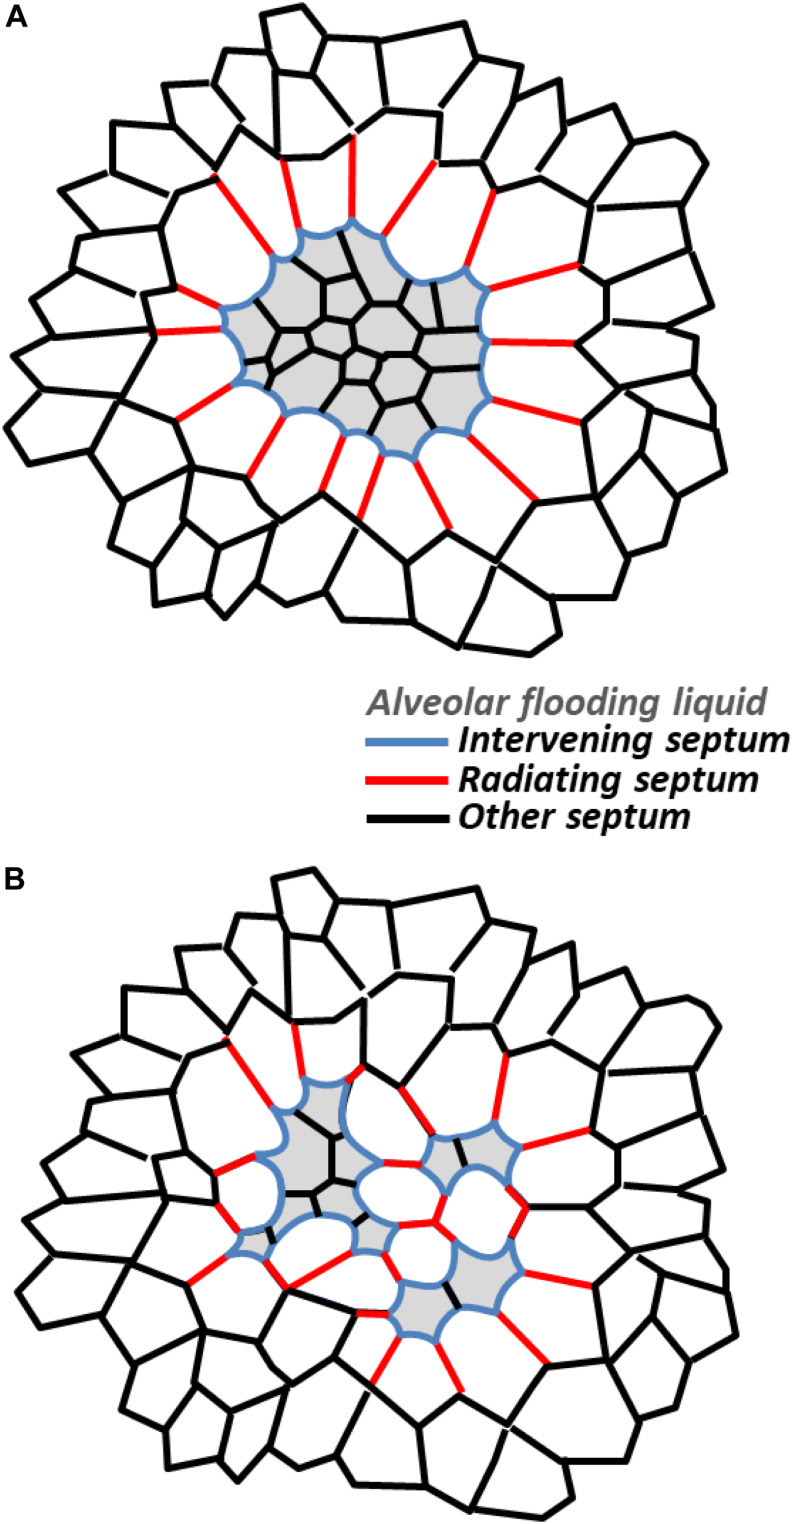
Stress concentrations in injured regions. Schematic representations showing stressed intervening and radiating septa in (A) homogeneously and (B) heterogeneously flooded regions. While only single layers of radiating septa are shown, computational modeling indicates radiating septa, especially those around a larger injured area, penetrate further into surrounding, aerated parenchyma (see text).